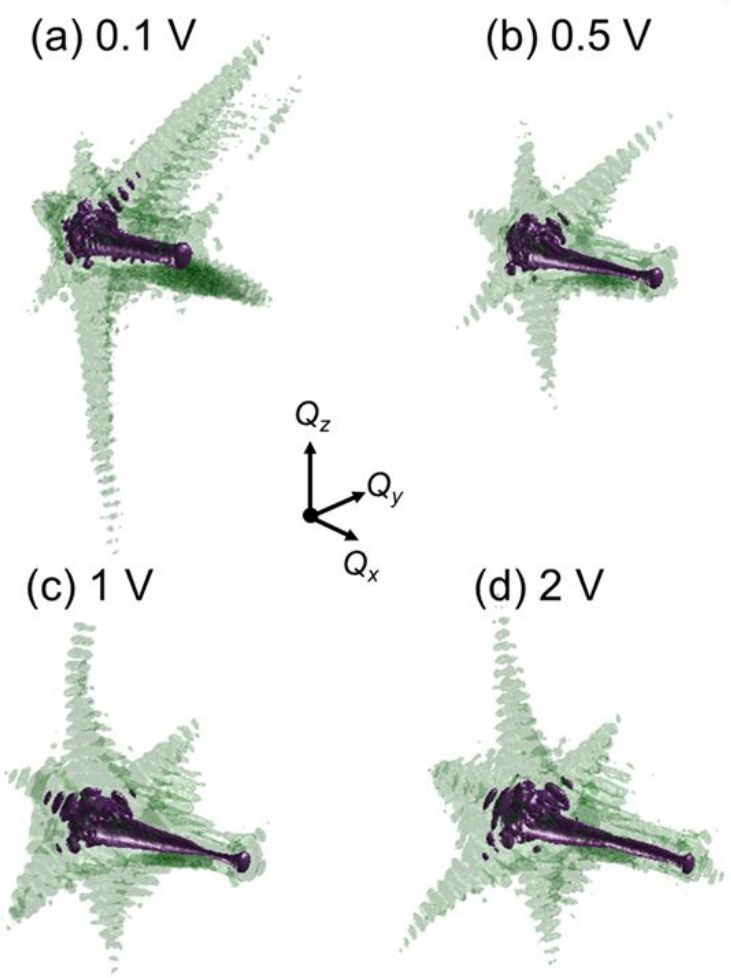
Figure 6. Evolution of intensity distribution around 10¯10 GaN Bragg reflection of a contacted GaN NW with the diameter of 350 nm. The values of the applied voltage bias: 0.1 V ( a ), 0.5 V ( b ), 1 V ( c ), 2 V ( d ). To enhance the diffraction pattern details, the intensity distributions are represented by two different iso-surfaces. The length of coordinate arrows corresponds to 0.1 nm − 1 . The intensity is normalized to the maximum and the iso-surface values are 10 − 3.4 and 10 − 4